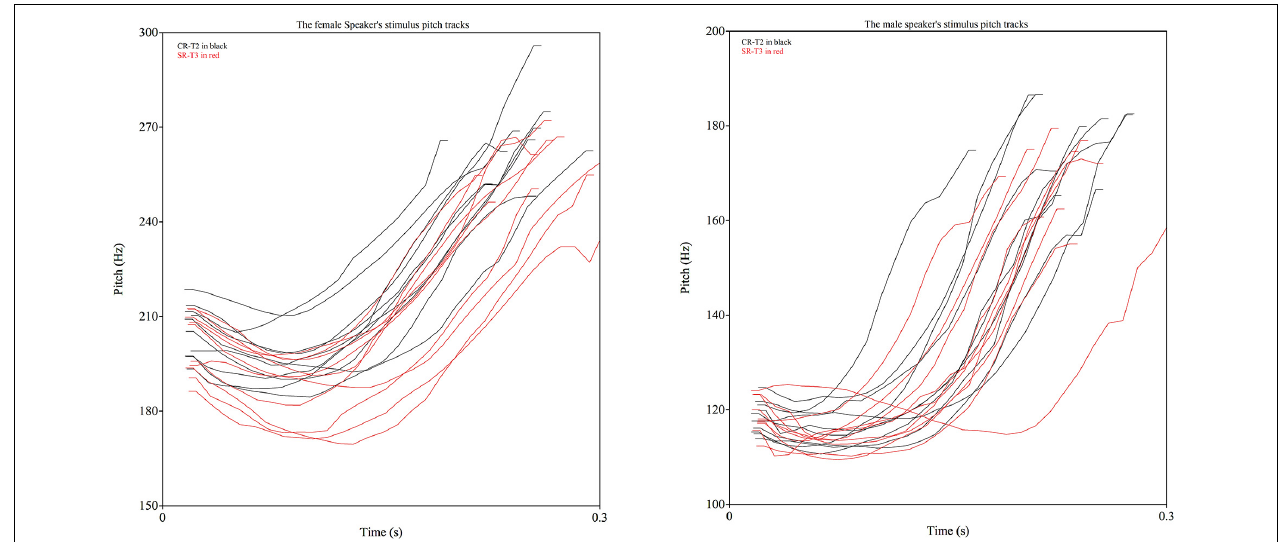
FIGURE 3 | Raw F0 tracks of the Sandhi-Rising T3 and Canonical-Rising T2 syllables for the female (left panel) speaker and male (right panel)